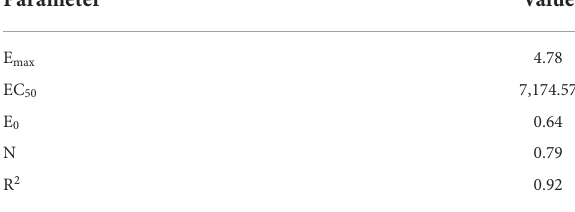
TABLE 3 The PK/PD parameters of tilmicosin against M. gallisepticum in vivo using the Emax model employed by WinNonlin software. Parameter